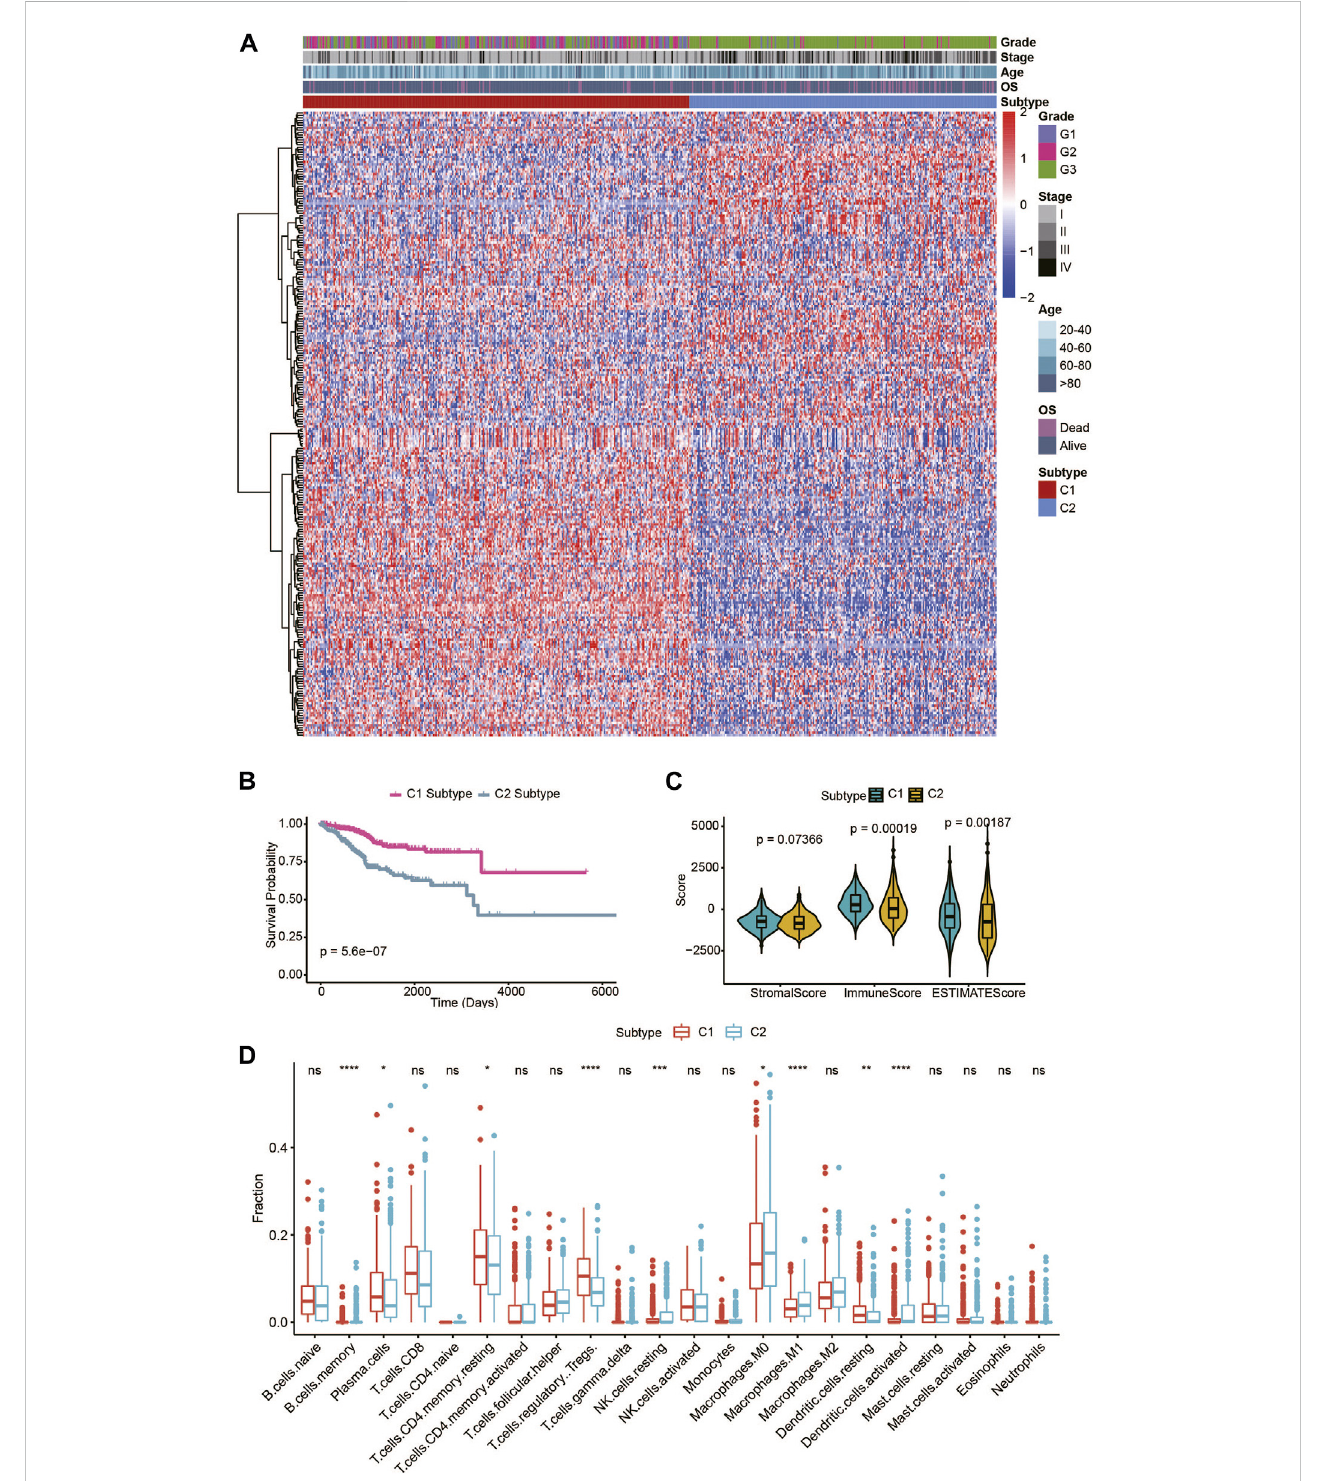
FIGURE 1 Identi fi cationoftwometabolicsubtypesinTCGAUCECpatients. (A) ConsensusclusteringofUCECpatientsbasedon255identi fi edmetabolicgenes. (B) OS of the two metabolic subtypes in the UCEC patients. (C) The violin plot of the stromal score, immune score, and ESTIMATE score of the two metabolic subtypes. (D) Immune cell components that differ between the two metabolic subtypes in UCEC patients.